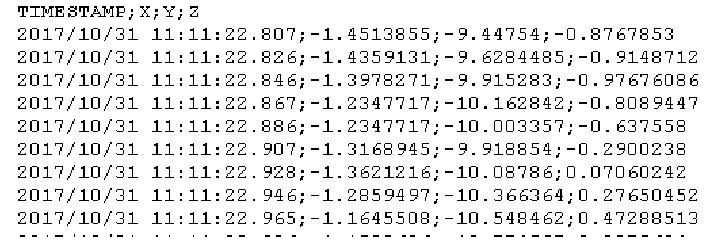
Figure 11. Excerpt from an acceleration.csv file